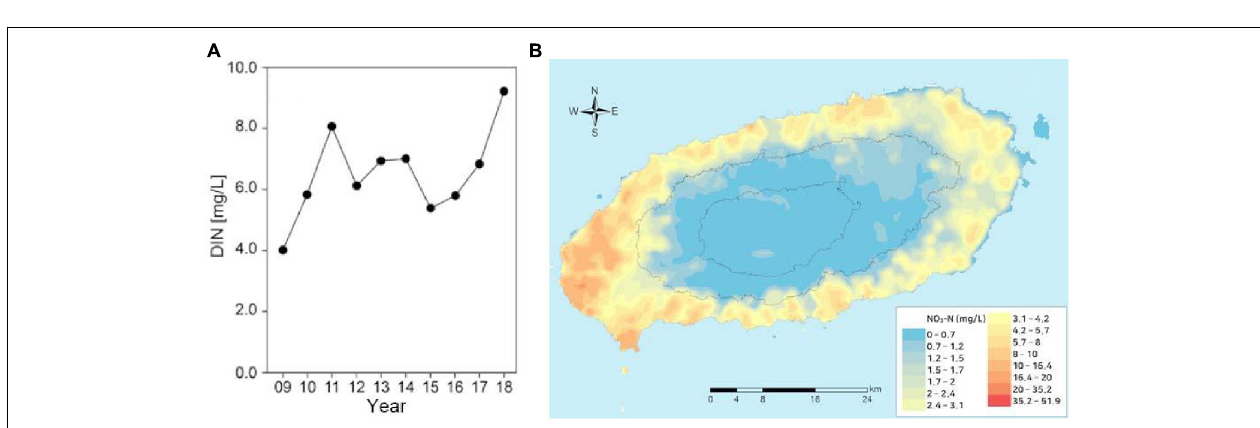
FIGURE 4 | The annual variation of DIN in groundwater samples around Hwasun region (A) and the distribution of nitrate concentration in groundwater in Jeju Island (B) .